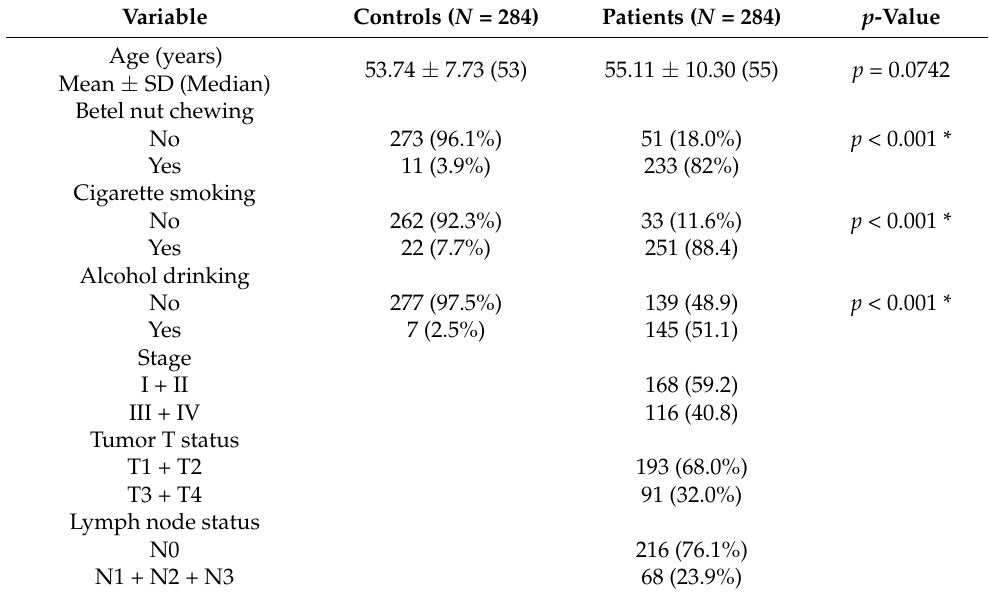
Table 1. The distributions of demographical characteristics and clinical parameters in 284 controls and 284 cases with